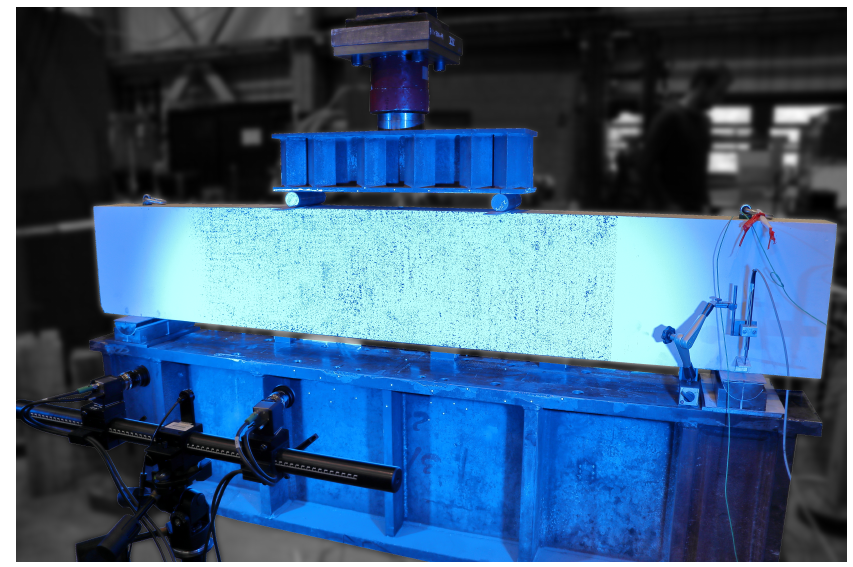
Figure 6. Photo of the test